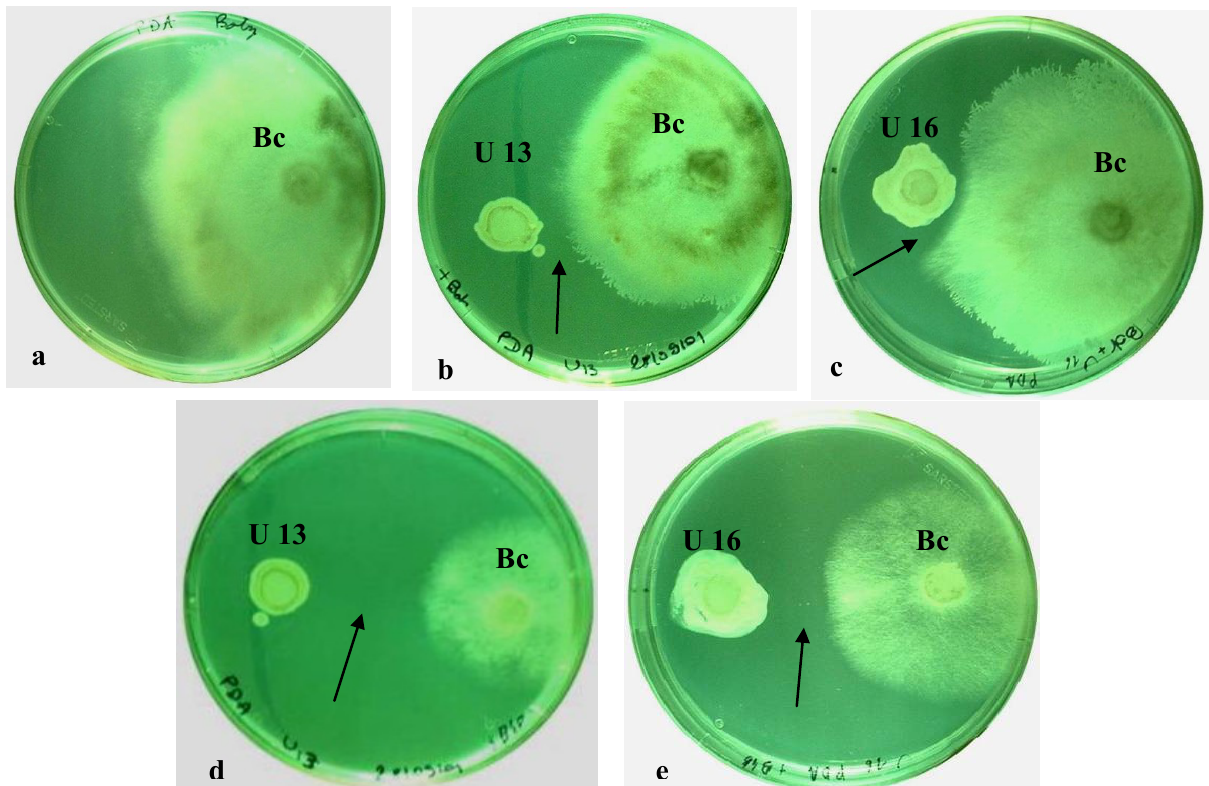
Figure 1. Antagonistic interaction between antagonists ( U. atrum U13 or U16) and B. cinerea . The pathogen was deposited simultaneously ( b , c ) or two days after U. atrum ( d , e ); The dual culture was incubated for three days at 20 °C. Note the inhibition zone between the two colonies (arrow); The test was repeated twice each with 10 replicates; a : control; b,d : B. cinerea vs . U. atrum U13; c,e : B. cinerea vs. U. atrum U16. B. cinerea (Bc); U. atrum U16 (U16); U. atrum U13